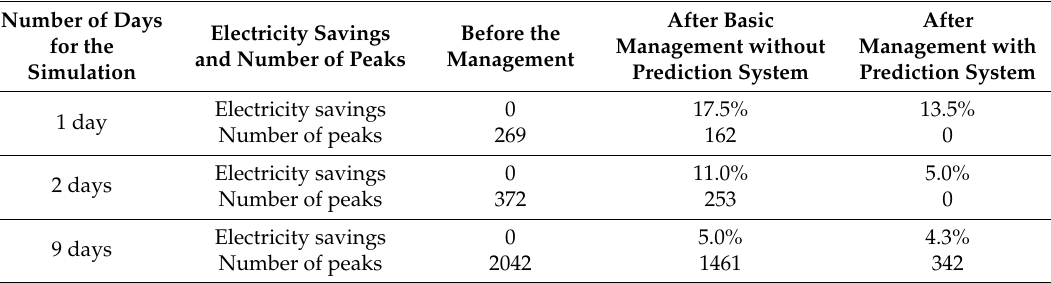
Table 6. Relevance of the new HEM algorithm implementing the STLF based on the fuzzy logic method, and, at the same time, peak demand smoothing.